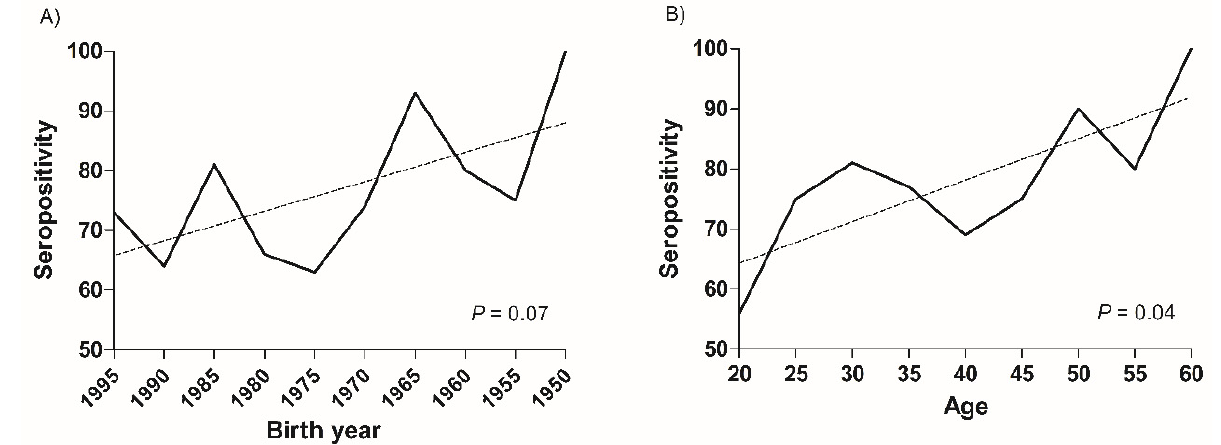
Figure 2. Changes of seroprevalence of measles in healthcare workers according to birth year and age groups. The seroprevalence of measles in healthcare workers decreased according to ( A ) the birth year groups ( p = 0.07) and ( B ) significantly decreased according to the age groups ( p = 0.04).